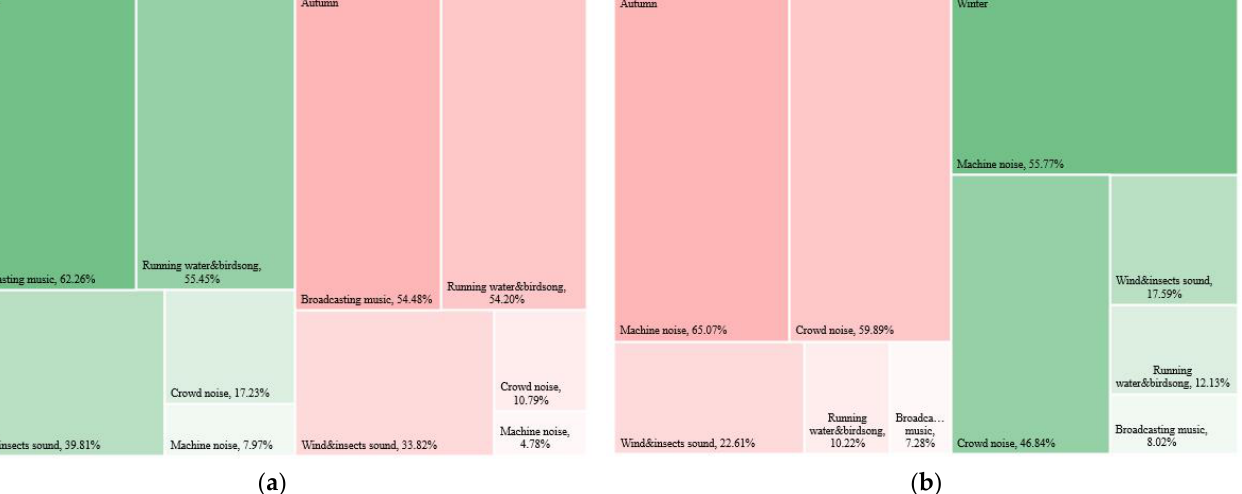
Figure 6. Distribution of the TSV among sound types. 3.4.2. Thermal Comfort at Different STPs We calculated the percentages of TCVs at different levels in the total number of votes at different STPs. In autumn, TCVs for “ d iscomfort” (TCV = −2, −1) were relatively high with machines (35.3%) and crowds (39.6%). The TCVs for “ c omfort”(TC V = 1, 2) with running water and birdsong (57.7%), wind (a gentle breeze) and insects (57.0%), and broadcasting music (56.7%) exceeded 50% and were basically equal, indicating the high